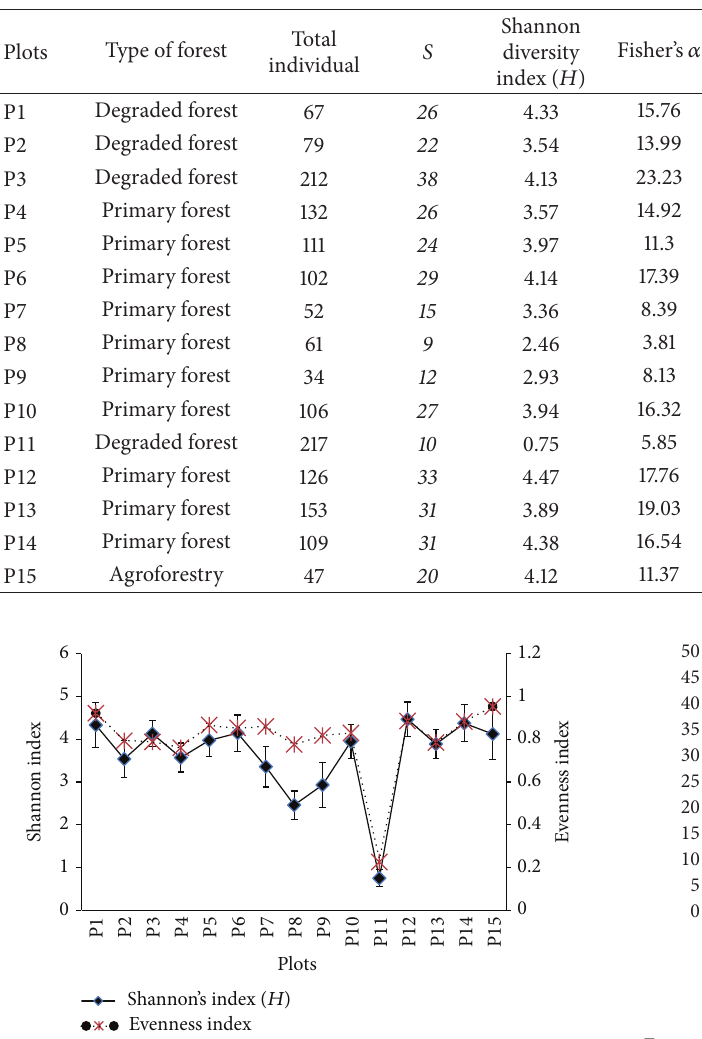
Table 3: Biodiversity values by biodiversities index and static parameters.